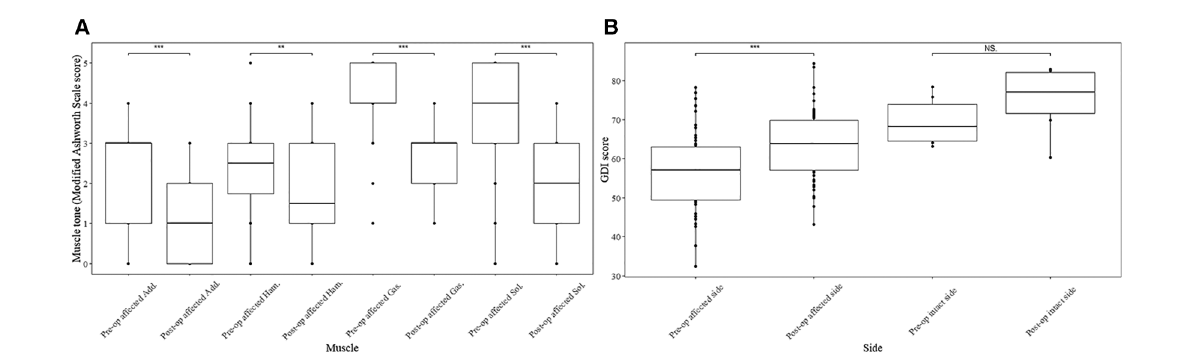
Bold values indicate statistical signi fi cance.